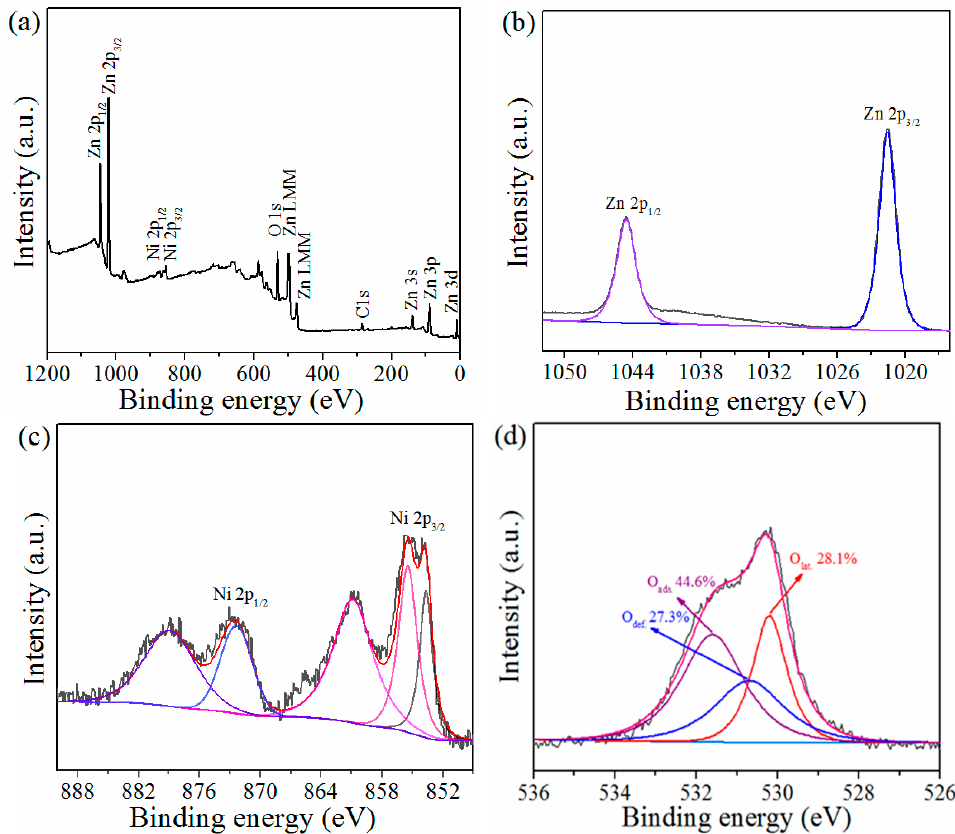
Figure 5. XPS spectra of porous urchin-like Ni-ZnO composites: ( a ) survey spectrum, ( b ) Zn 2p, ( c ) Ni 2p, and ( d ) O 1s spectra. ( c ) Ni 2p, and ( d ) O 1s